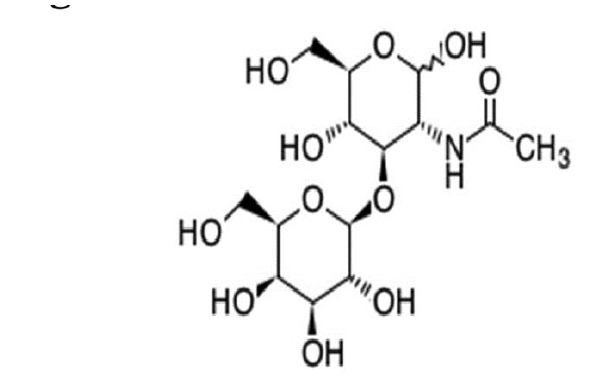
Fig. 1. Lacto- N -biose